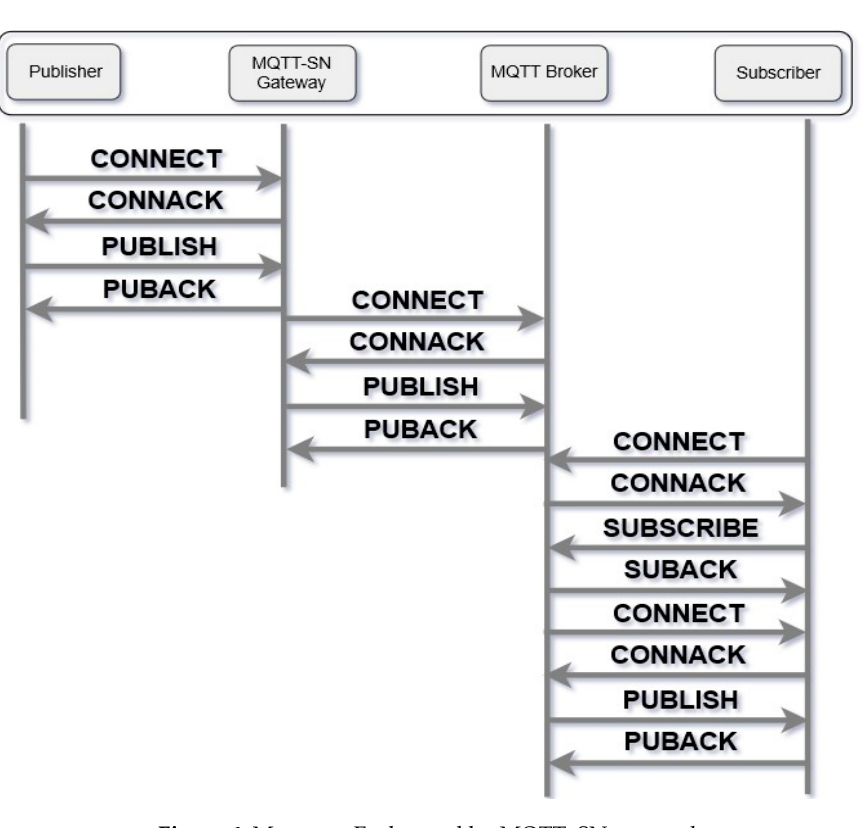
Figure 6. Messages Exchanged by MQTT_SN